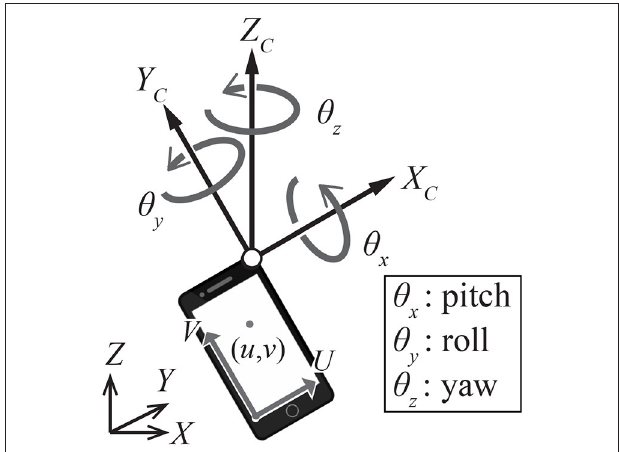
FIGURE 1 | Definitions of smartphone’s 6DoF and 2-D